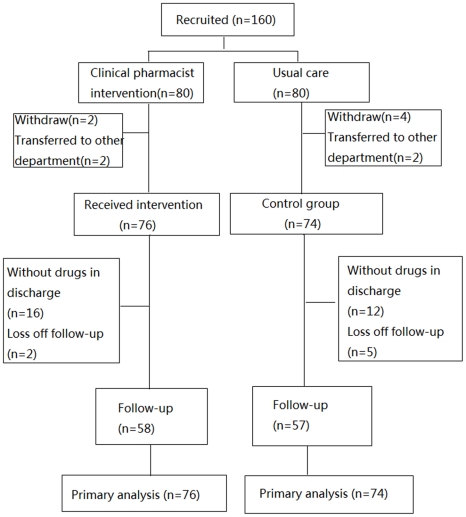
Trial flow chart.